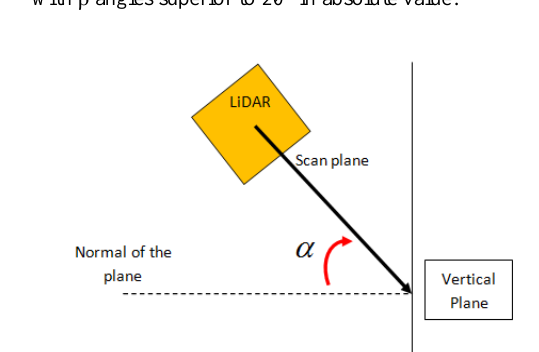
Figure 6: Vertical plan scanned with an α angle (view from above)